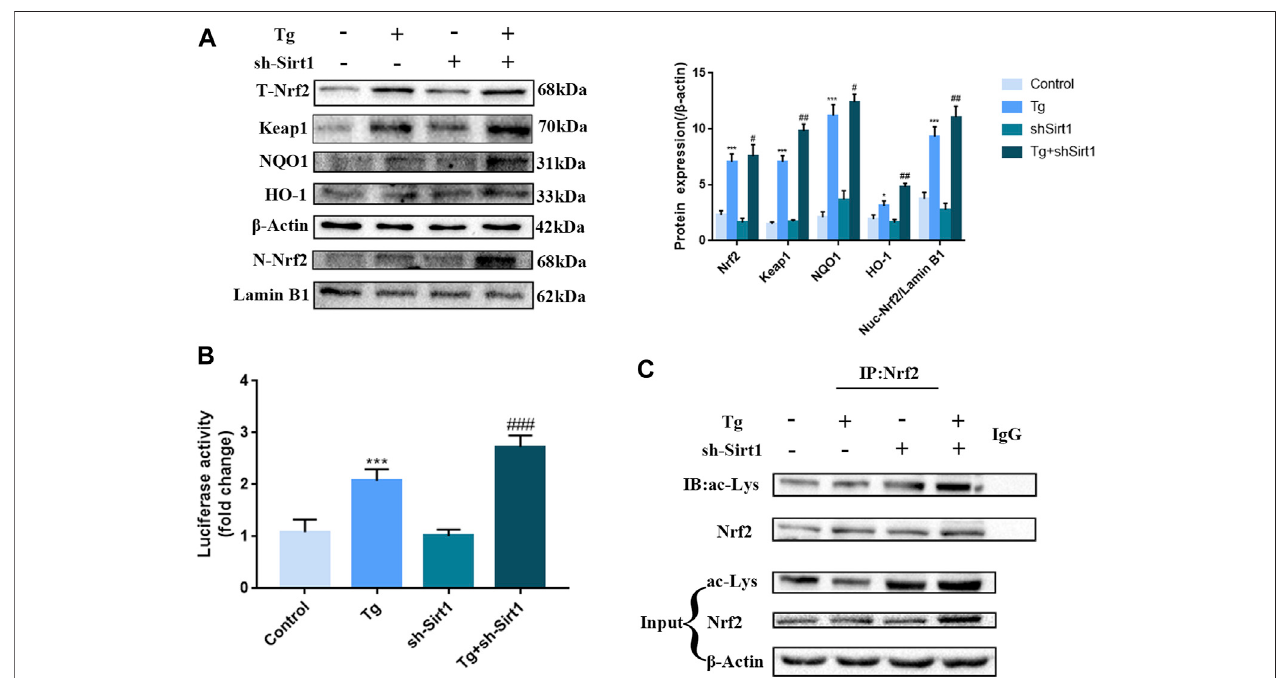
FIGURE7| Theknock-downofSIRT1byshRNAincreasesNrf2nuclearaccumulationandacetylationinTg-inducedCaco-2cells. (A) Effectsofsh-SIRT1ontotal- Nrf2,Keap1,nuclear-Nrf2,NQO1 andHO-1proteinexpression levelsinTg-induced Caco-2cellswereassessed bywesternblotanalysis. (B) Effects ofsh-SIRT1 onthe relative fl uorescence intensity of NRF2/ARE in Tg-induced Caco-2 cells were measured using the Dual Luciferase Reporter Gene Assay Kit. (C) Effects of sh-SIRT1 on Nrf2 acetylationlevels weredetermined inTg-induced Caco-2 cells by co-immunoprecipitation assays.Dataare presented asthe mean ±SEM ( n = 3). Statistically signi fi cant differences are indicated; * p < 0.05, ** p < 0.01, *** p < 0.001, signi fi cantly different from control group. # p < 0.05, ## p < 0.01, ### p < 0.001 signi fi cantly different from Tg